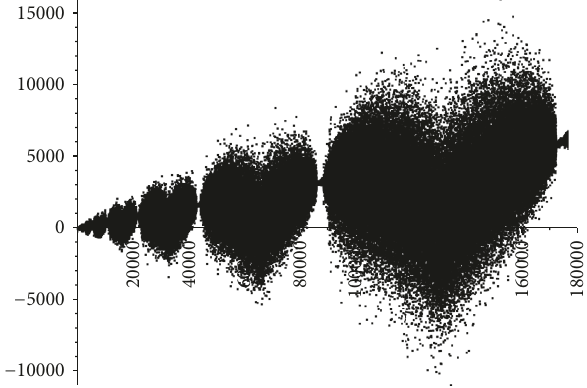
Figure 7: Heart sequence 𝐻 𝑏 (𝑛) = 𝐶(𝑛) − 𝑄 𝑏 (𝑛) .